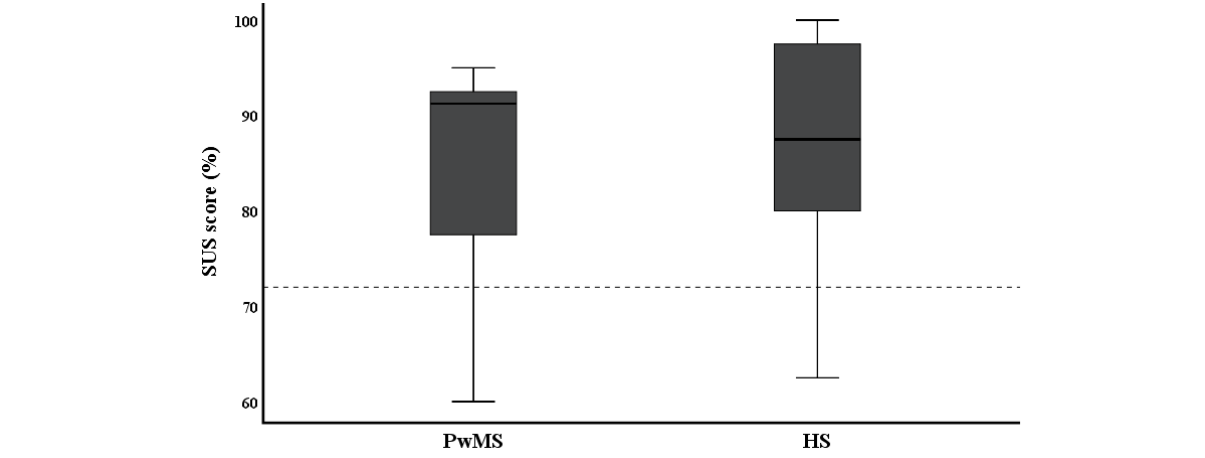
Figure 2. Results of the System Usability Scale (SUS). The SUS score ranges from 0% to 100%, where a higher value indicates better system usability. The dotted line represents a score of 71.4%. A score of 70% up to a maximum 100% represents acceptable-to-excellent usability. PwMS: persons with MS; HS: healthy